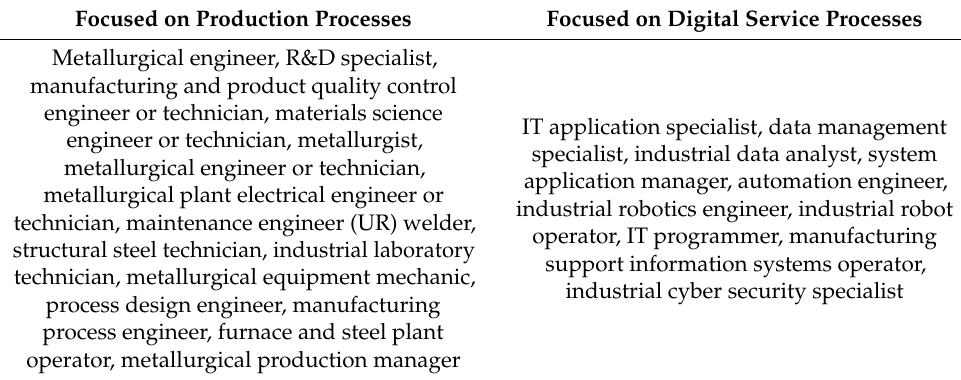
Table 4. Examples of occupations in the steel